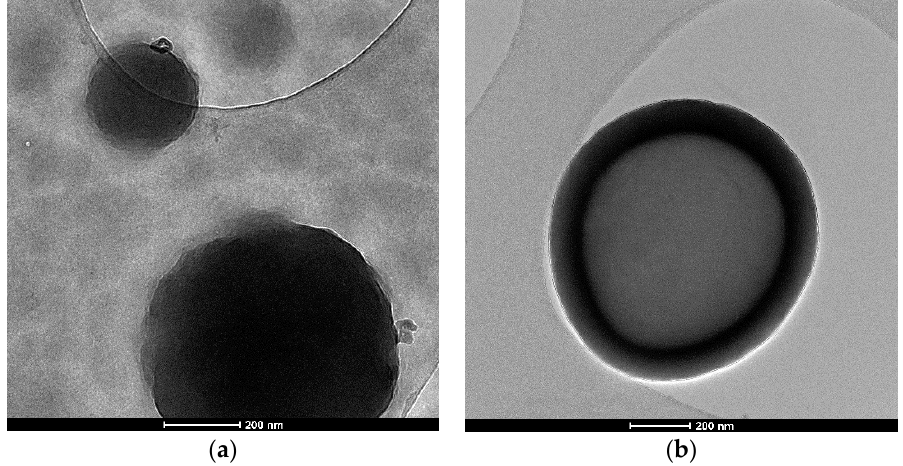
Figure 14. TEM images presenting the core-shell structure of synthetized ( a ) PUF-DCPD and ( b ) MUF-ENB microcapsules.